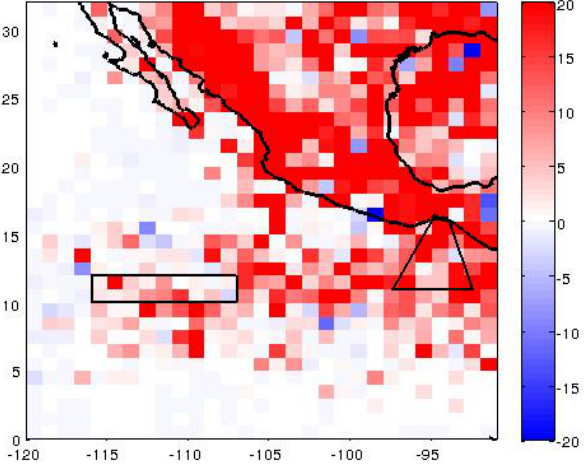
Fig. 14. Differences between average numbers of lightning flashes registered during days with high AOD (0.4–1.5) and moderate AOD